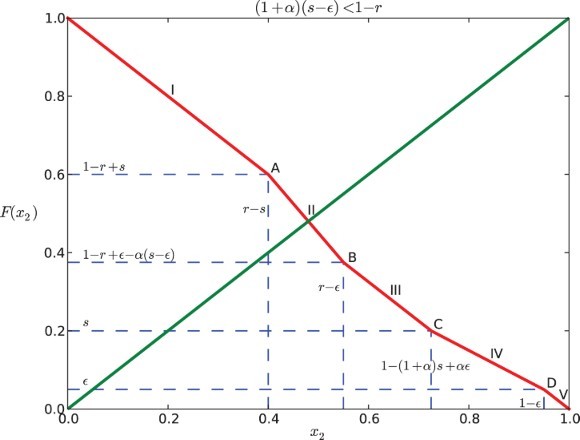
Return map F for Case I when α=0.5, s=0.2, r=0.6, and ε=0.05.